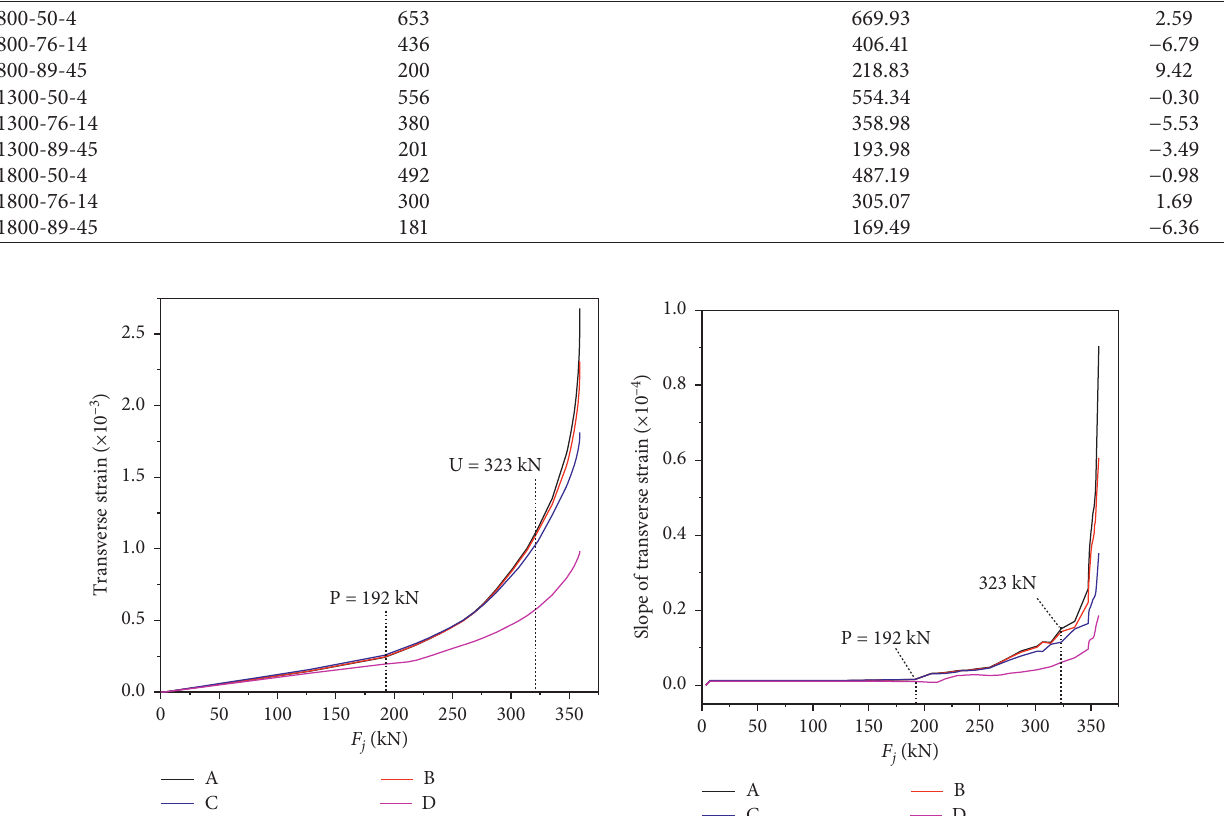
− F j curves of different